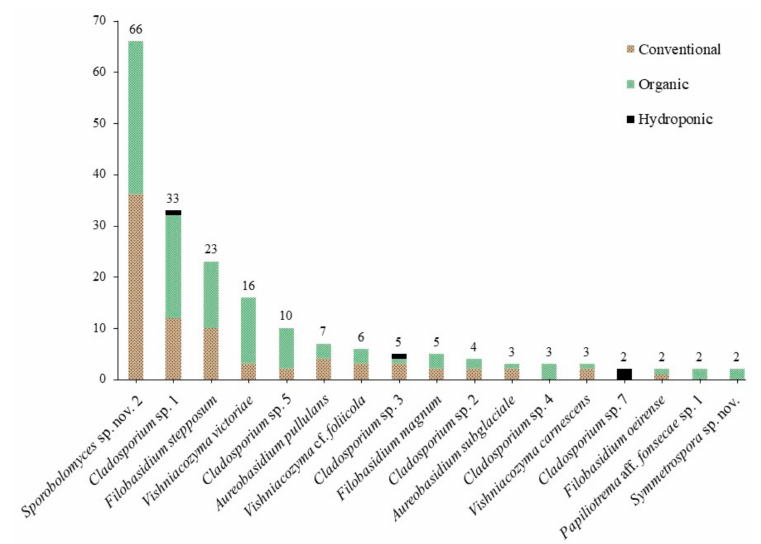
Figure 2. Number of isolates by treatment (conventional, organic, hydroponic) for “core” community species with 2 or more isolates.